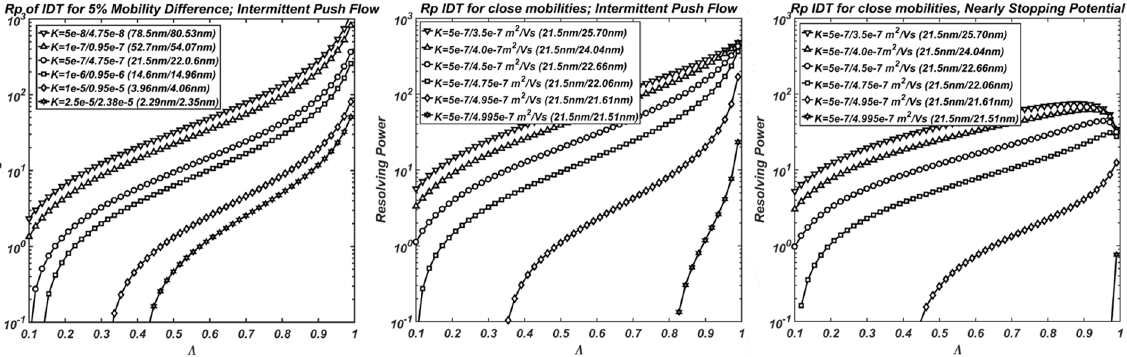
Figure 9. Resolving Power R p as a function of separation ratio Λ for: ( A ) Ranges of ions with mobilities that differ 5% (2.23% in diameter) using Intermittent Push Flow. ( B ) An Ion with Mobility of 5e-7 m 2 /Vs (21.5 nm) with respect to ions that differ between 30% and 0.1% in Mobility for Intermittent Push Flow. ( C ) Same as ( B ) but for Nearly-Stopping